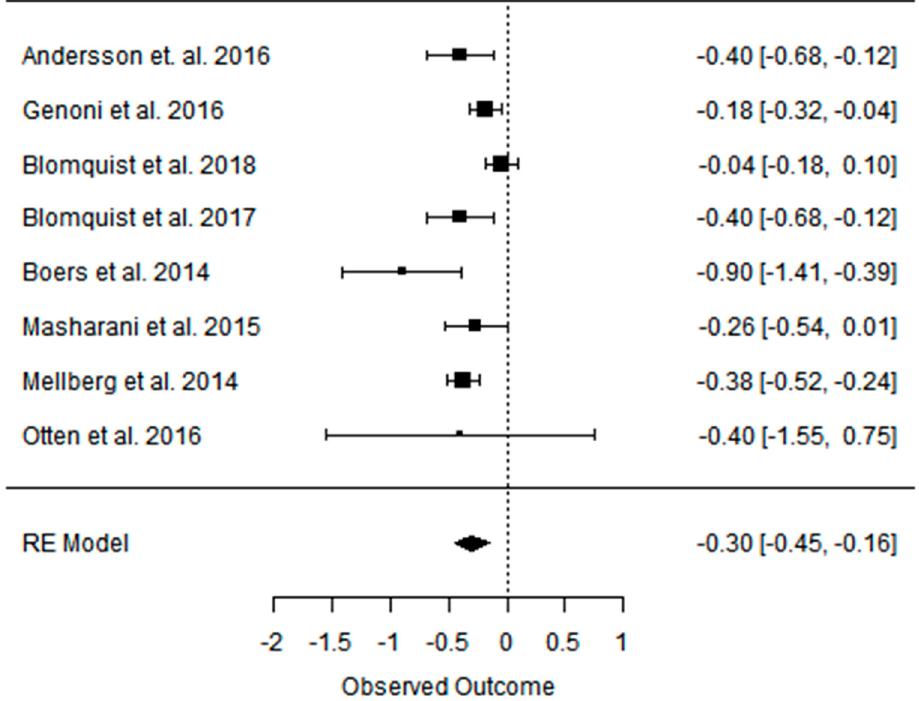
Figure A18. Forest plot of the effect of PD on TG in the short term (weighted mean difference).